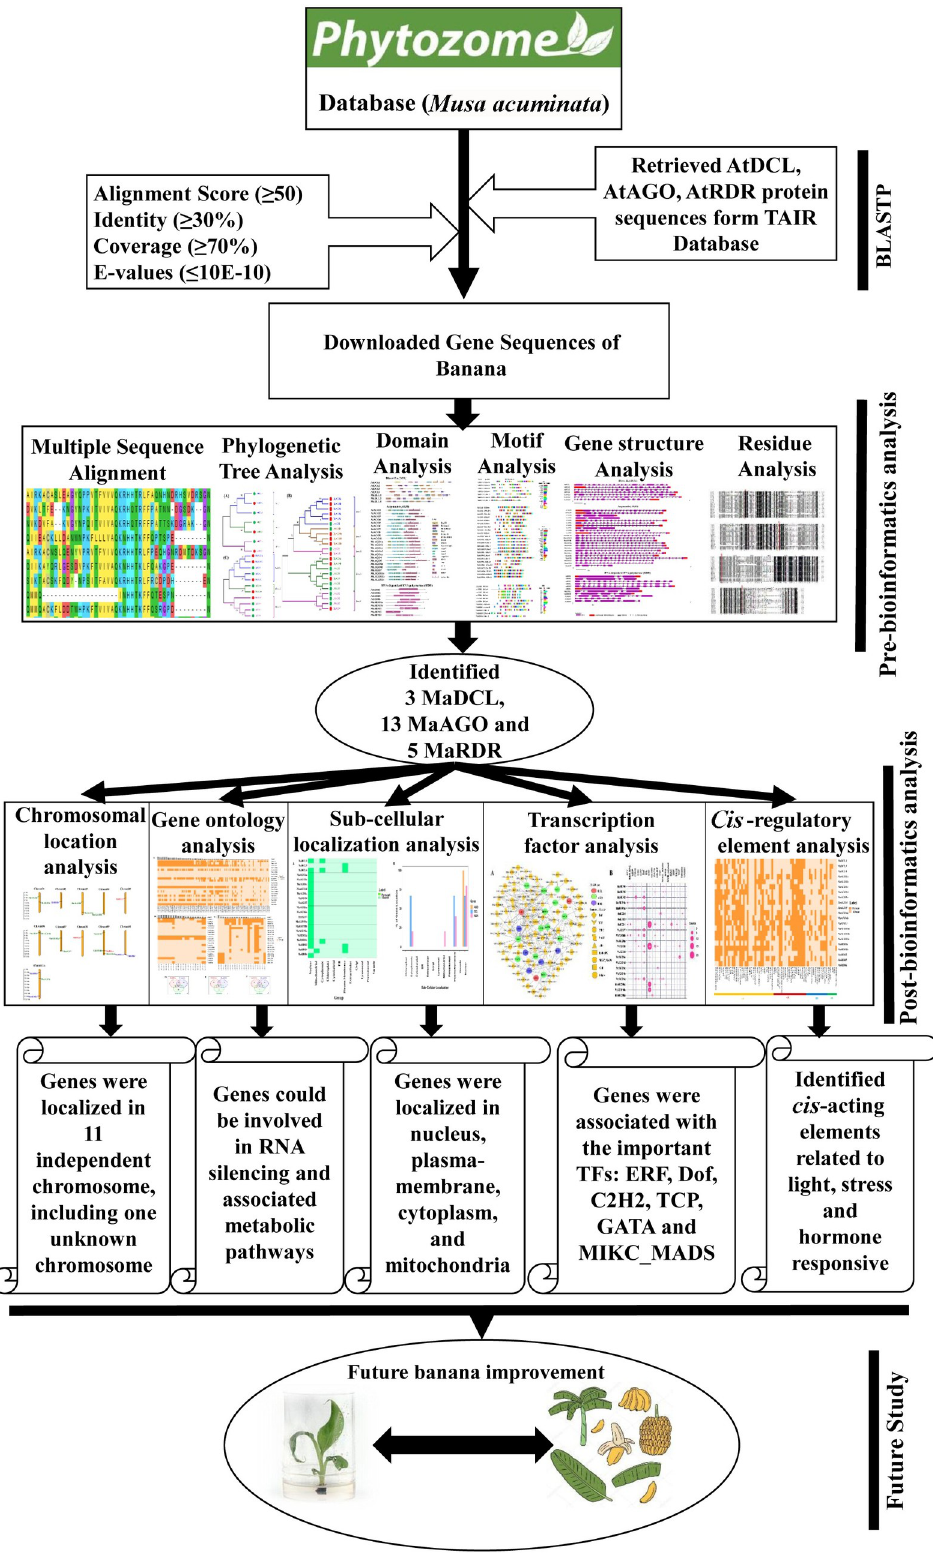
Fig 1. A graphical abstract of our